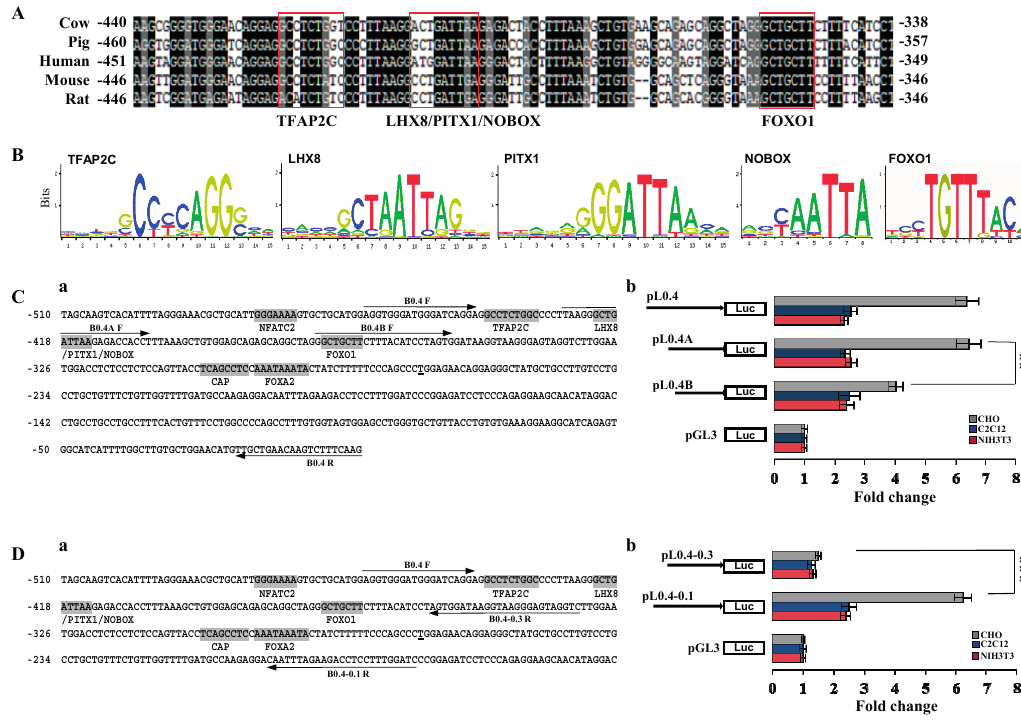
Figure 4. Functional analysis of regulatory elements in porcine BMP15 promoter. ( A ) Alignment of BMP15 promoter sequences among animal species. The potential DNA binding sites are highlighted in boxes; ( B ) The consensus sequences of TFAP2C, LHX8, PITX1, NOBOX, and FOXO1 are predicted by JASPAR program (jaspar.genereg.net); ( C ) The proximal sequence (–460 to –1 bp) of BMP15 promoter has multiple potential DNA binding sites ( a ). Luciferase assays were performed with different deletion constructs in CHO, C2C12, and NIH3T3 cells ( b ); and ( D ) Partial proximal sequence ( − 460 to − 175 bp) of BMP15 promoter region ( a ). Luciferase assays were performed with different deletion constructs in CHO, C2C12, and NIH3T3 cells ( b ). The primer sequences used to generate the deletion are indicated by arrows. Values are represented as mean ± SD; ** p < 0.01; *** p < 0.001; n =